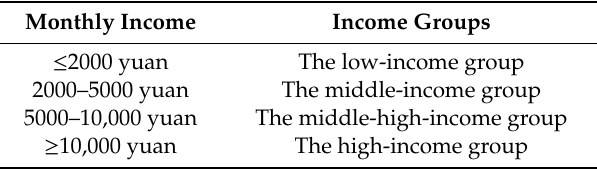
Table A1. The classification standards for di ff erent income groups from the National Bureau of Statistics of